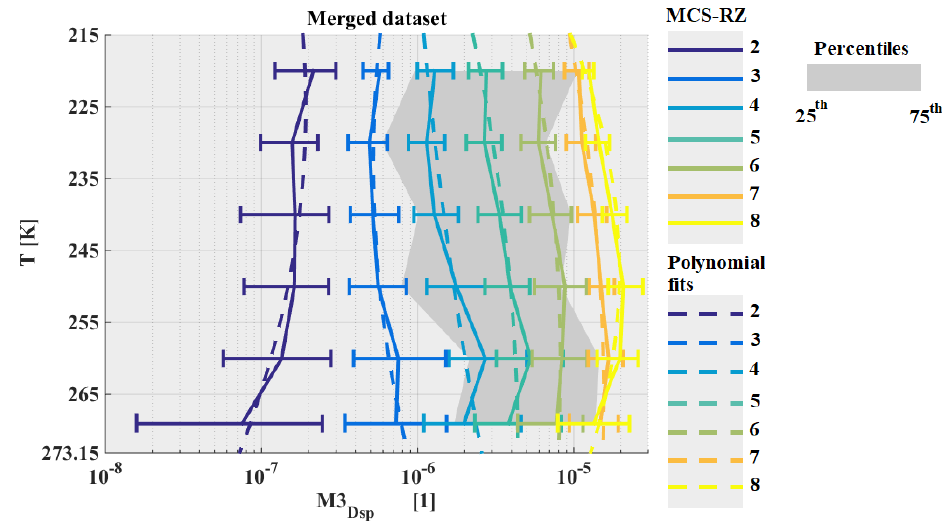
Figure E3. The same as Fig. 5 but for M 3 , Dsp m − 1 , where PSD is used as a function of equivalent spherical diameter.